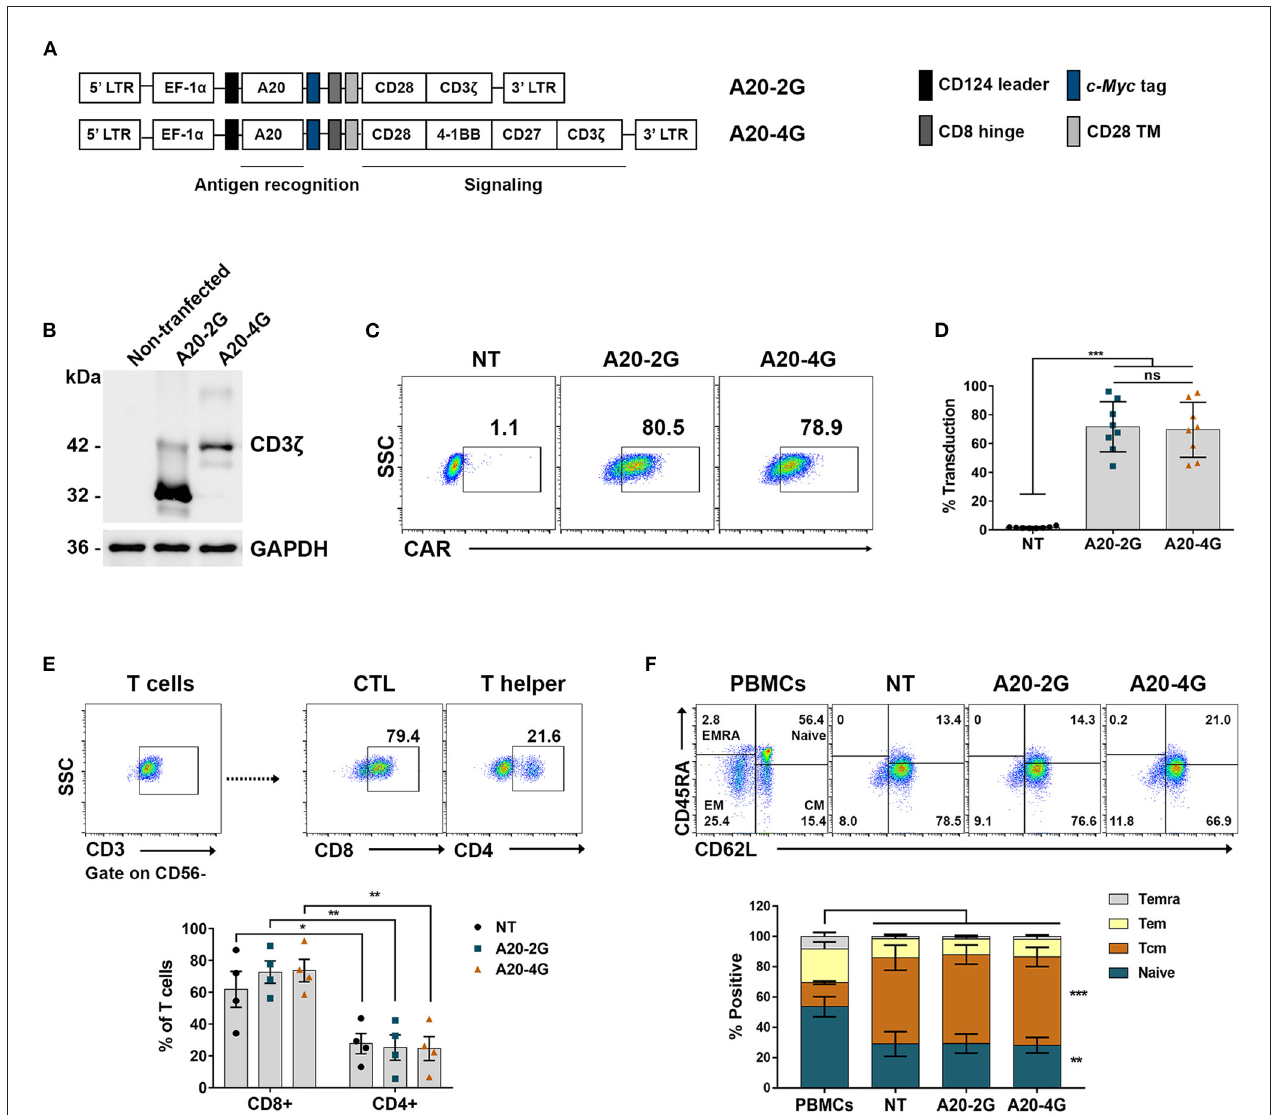
FIGURE 3 | Generation of chimeric antigen receptor (CAR) T cells targeting integrin α v β 6. (A) The schematic map demonstrates the A20-2G and A20-4G CAR constructs. The sequence of A20 (integrin α v β 6-targeting ligand) was cloned in-frame into lentiviral vectors linked with the sequences of CD8 hinge,